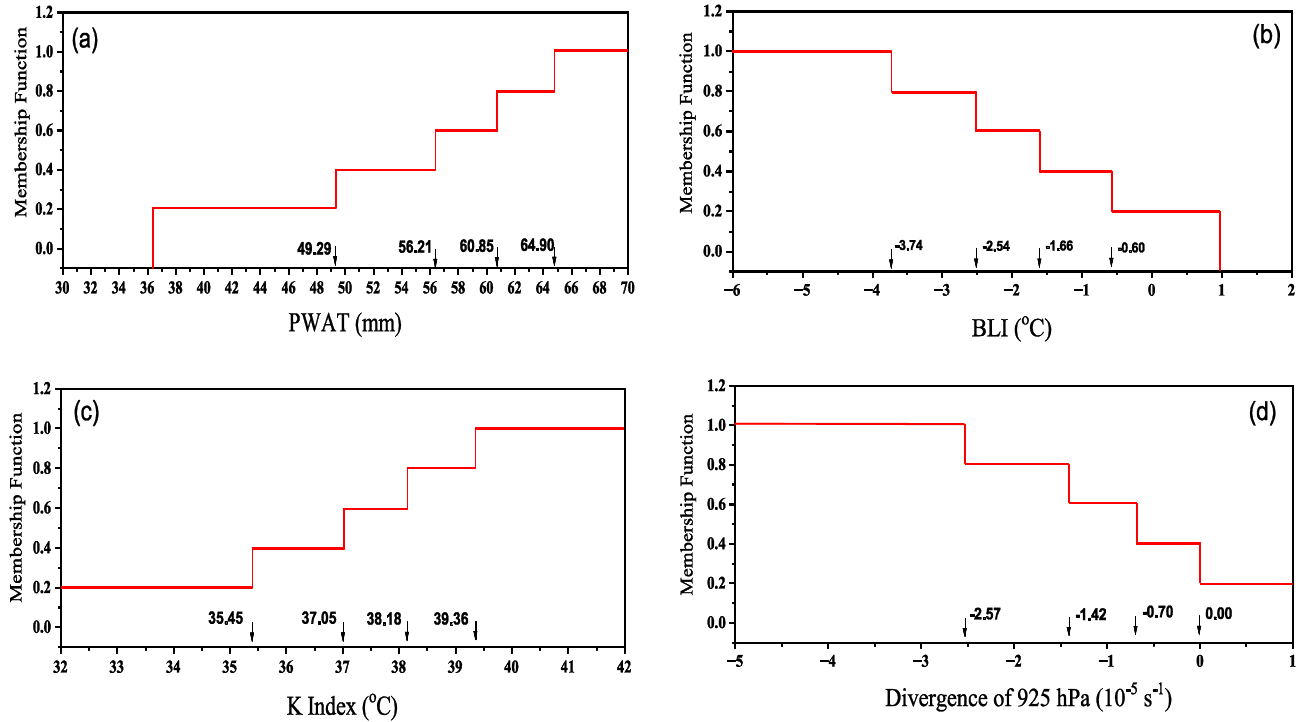
Figure 4. Membership functions of ( a ) PWAT, ( b ) BLI, ( c ) KI, and ( d ) DIV 925 . The values and arrows indicate the thresholds used for the grade division of the membership functions. Table 2. Thresholds of parameters used to define SDHR.